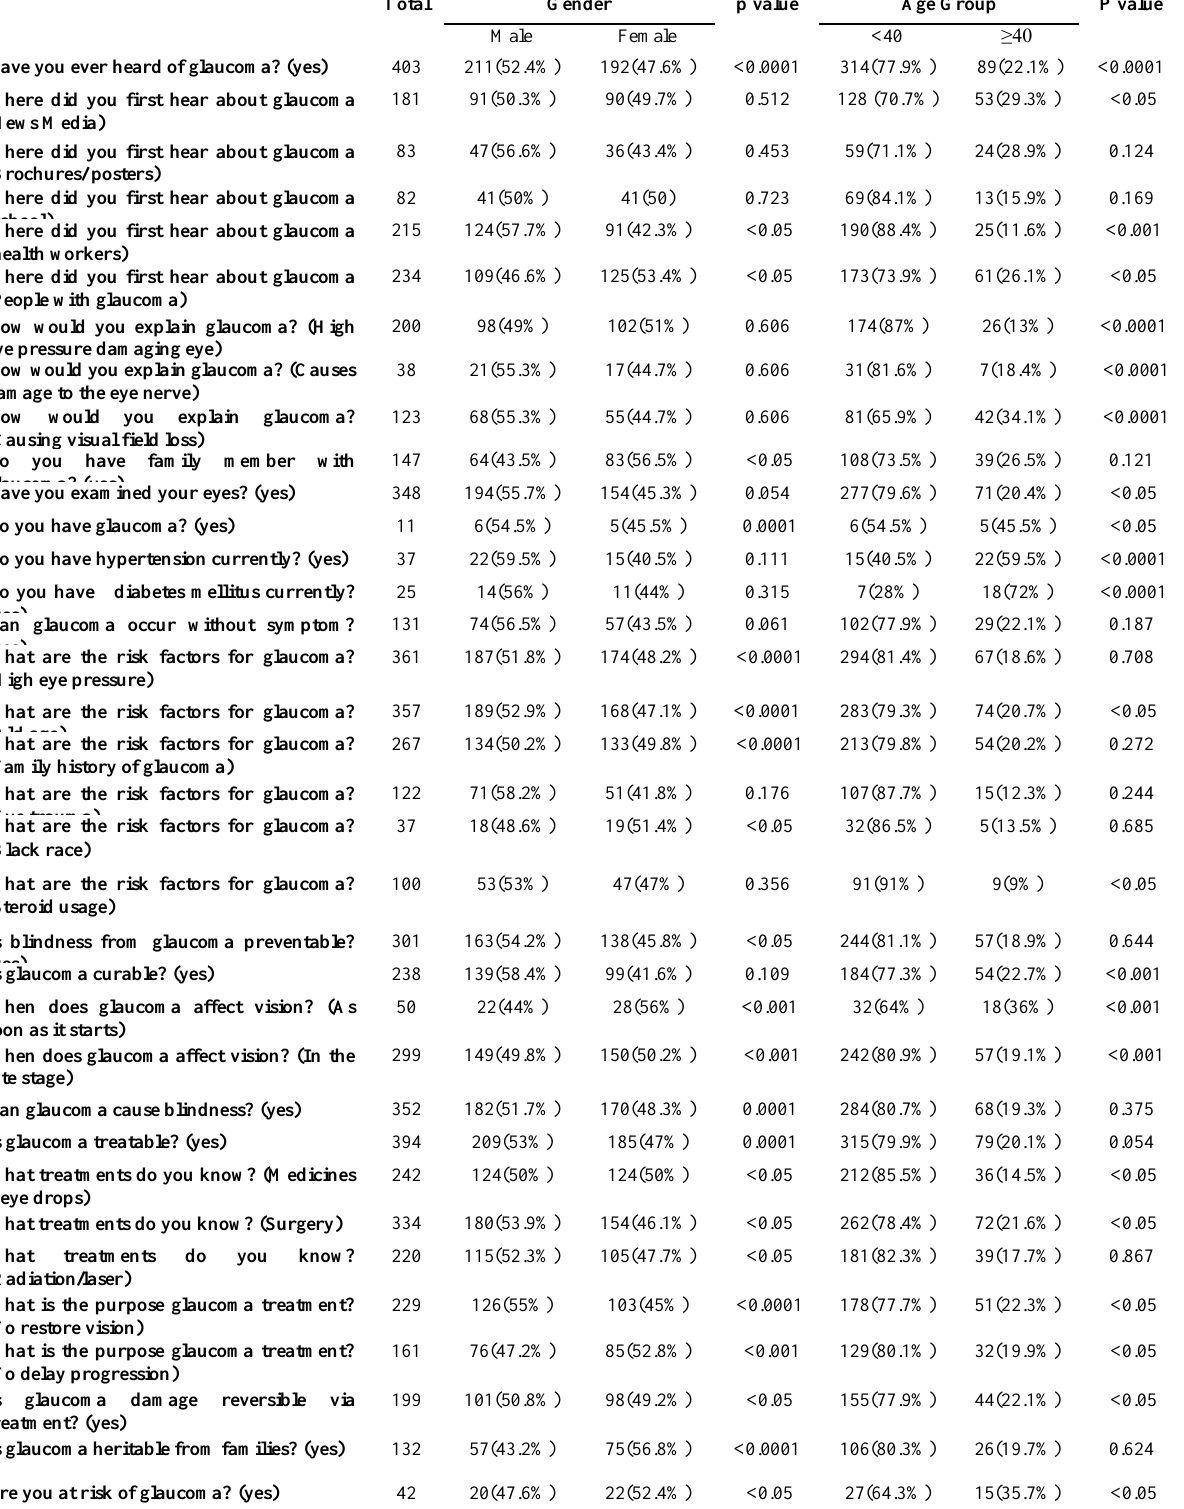
Table 2. Awareness and knowledge about Glaucoma in comparison to age group and gender Total Gender p value Age Group P value Male Female <40 ≥40